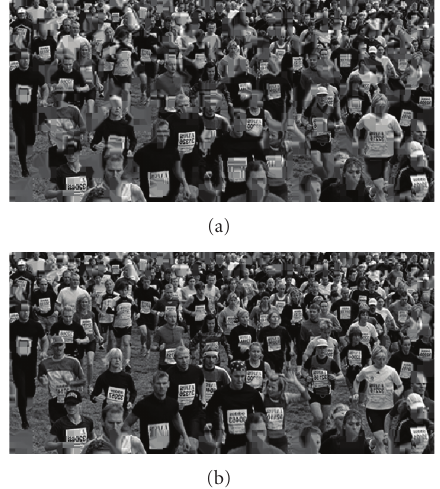
Figure 10: Crowd Run sequence detail with disabled (a) and enabled (b) ROI.